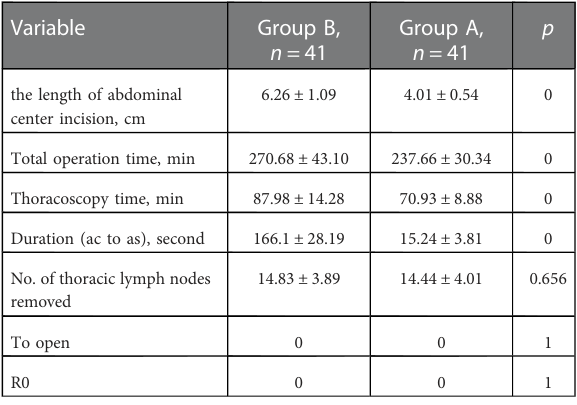
TABLE 2 Intraoperative data in two-ropes group Bnd regular